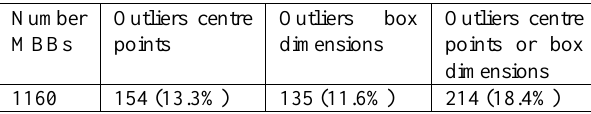
Table 2. Number of outliers detected by two